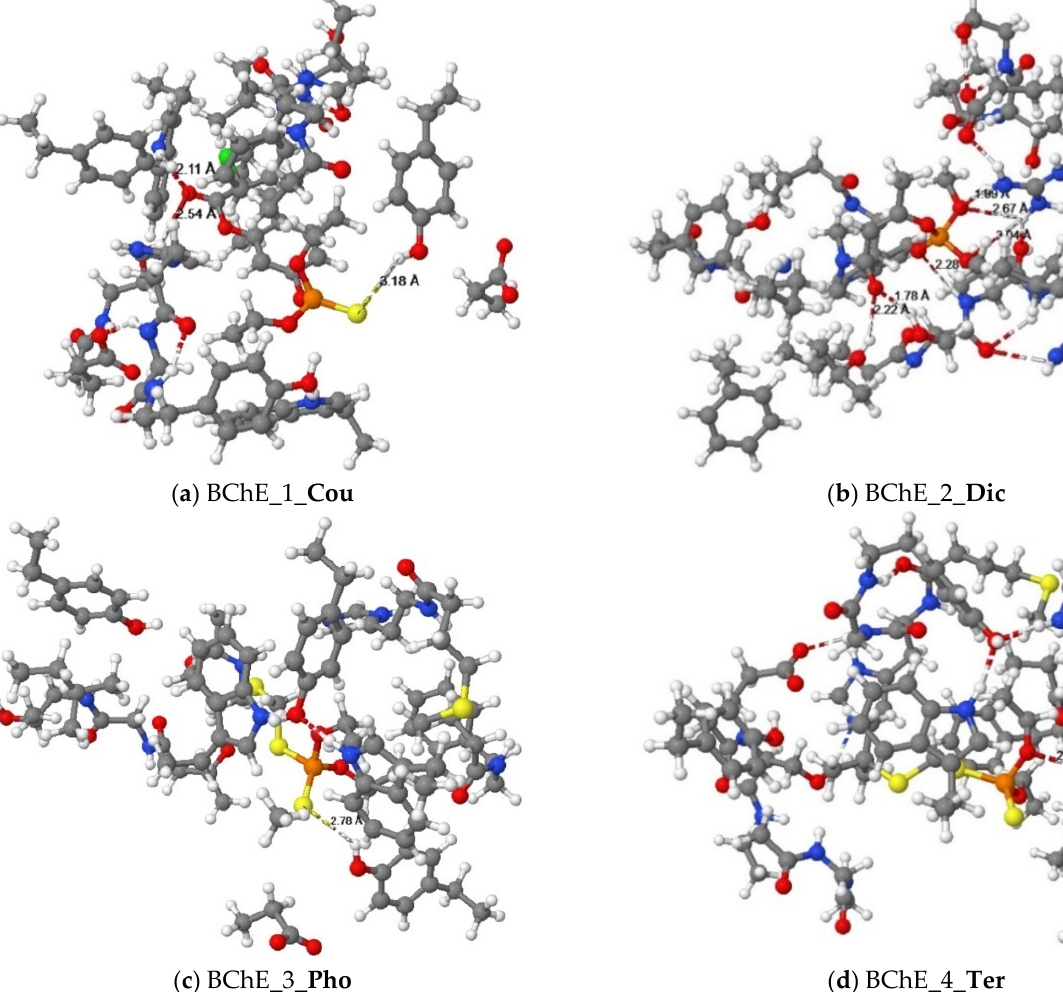
Figure 4. Equilibrium structures of organophosphorus pesticides (( a ) Cou , ( b ) Dic , ( c ) Pho, and ( d ) Ter ) binded with cluster models of the human BChE enzyme.